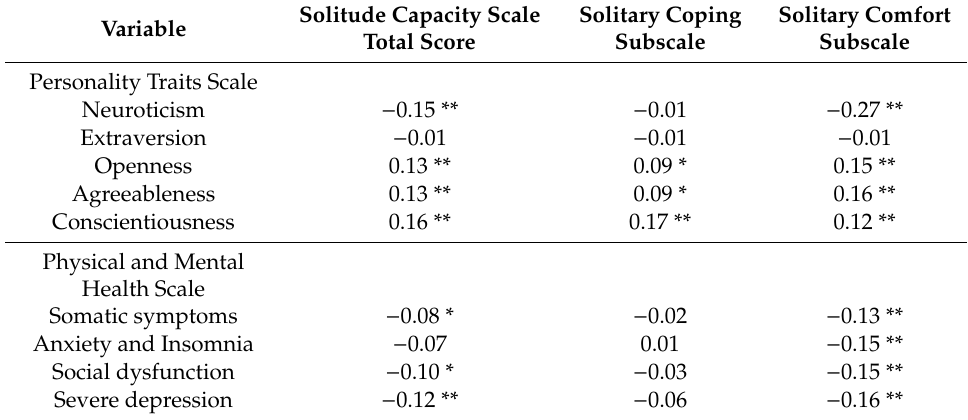
Table 2. Correlation coe ffi cients between the Solitude Capacity Scale and the Personality Traits Scale as well as the Physical and Mental Health